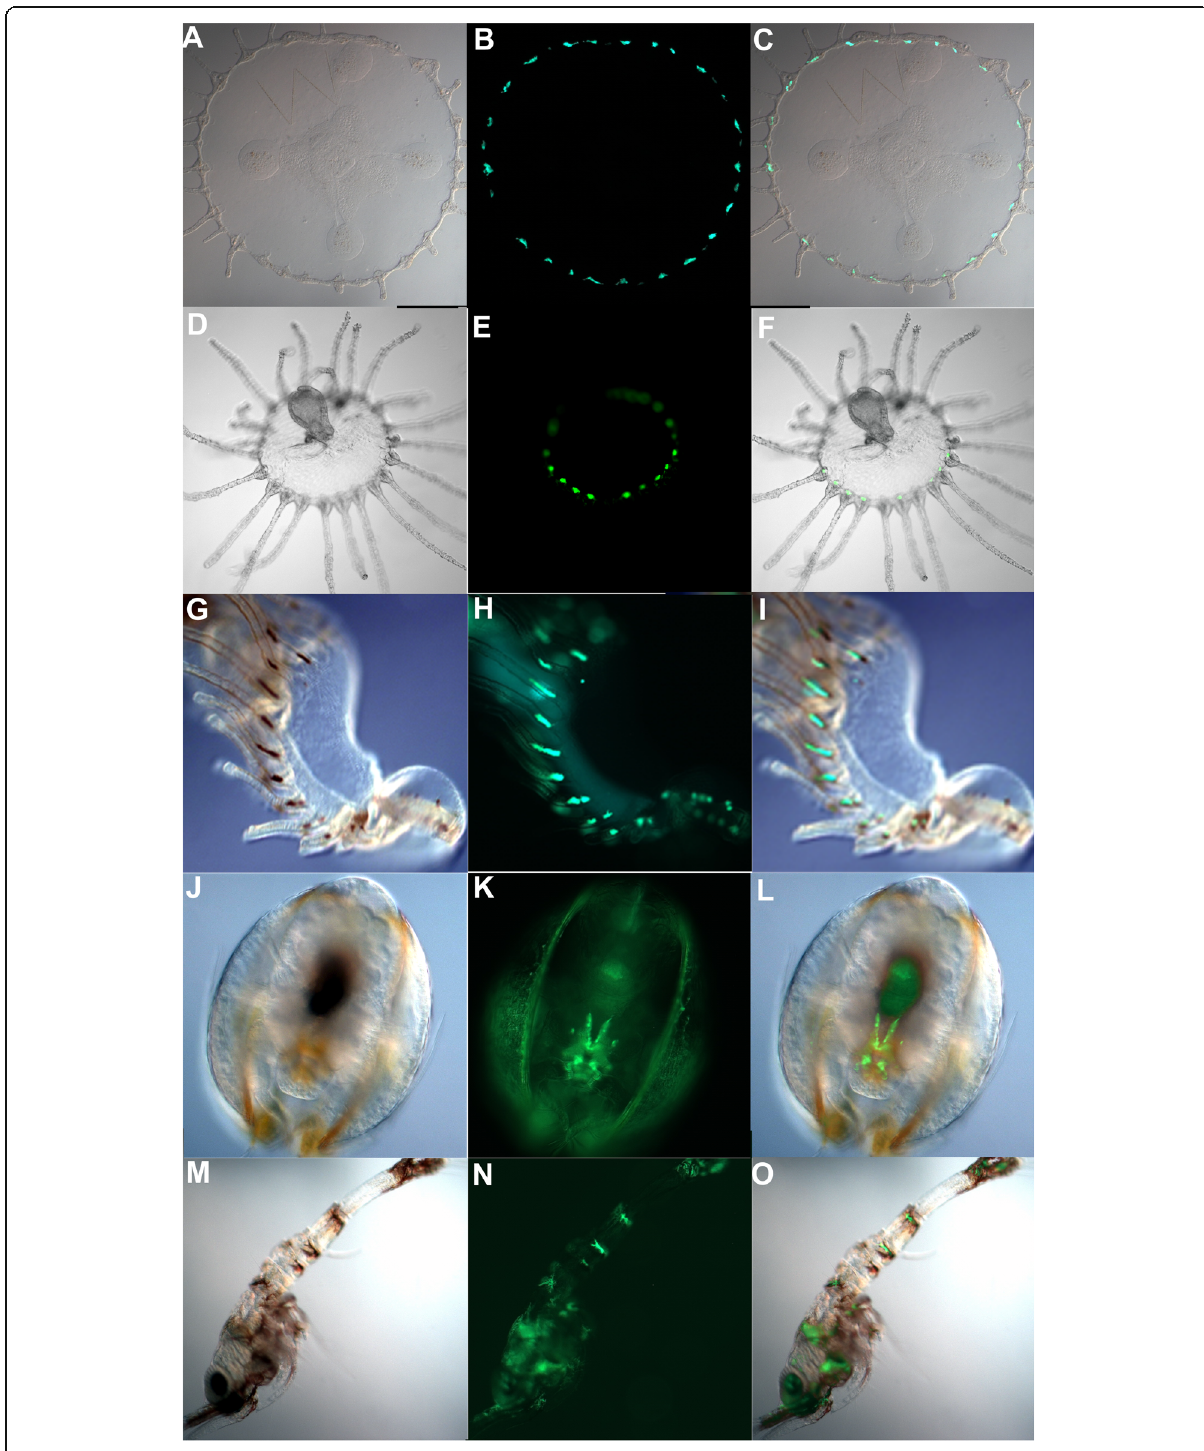
Fig. 1 Samples of GFP in cnidarians and pigment generated by fluorescent organisms from the Gulf of Naples (Italy). a – f : Cnidarian hydrozoans, Clytia hemisphaerica a – c and Obelia sp. d – f ; g – i : Phoronida, actinotroch larva of unknown species; j – o : Arthropoda, unknown ostracod species j – l and unknown crustacean species